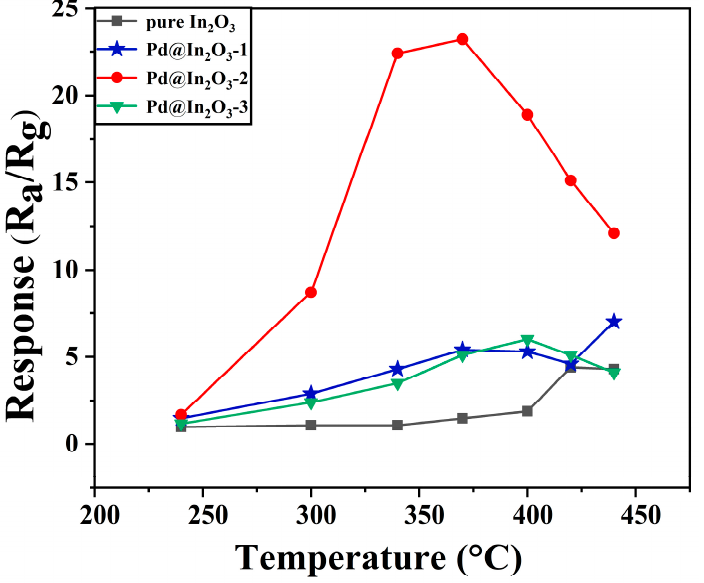
Figure 6. Gas response of pristine In 2 O 3 , Pd@In 2 O 3 -1, Pd@In 2 O 3 -2, and Pd@In 2 O 3 -3 to 5000 ppm CH 4 at different temperatures. High sensitivity is not the only criterion for evaluation of the gas sensors. The real-